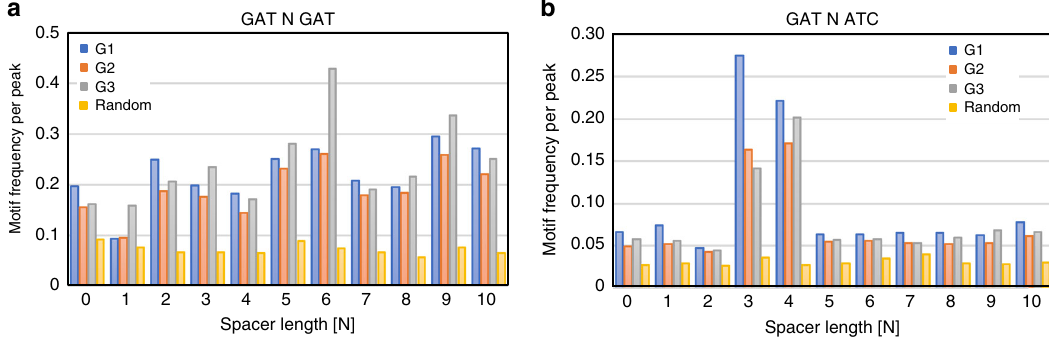
Fig. 6 Tandem GAT motif enrichment at GATA3 peaks. The basepair numbers between 5 ′ -GAT-3 ′ and 5 ′ -GAT-3 ′ (or 5 ′ -ATC-3 ′ ) are indicated on the horizontal axis. a GATnGAT frequency in each GATA3 peak group. b GATnATC frequency in each peak group. Random genomic regions were selected by using shuf fl eBed in